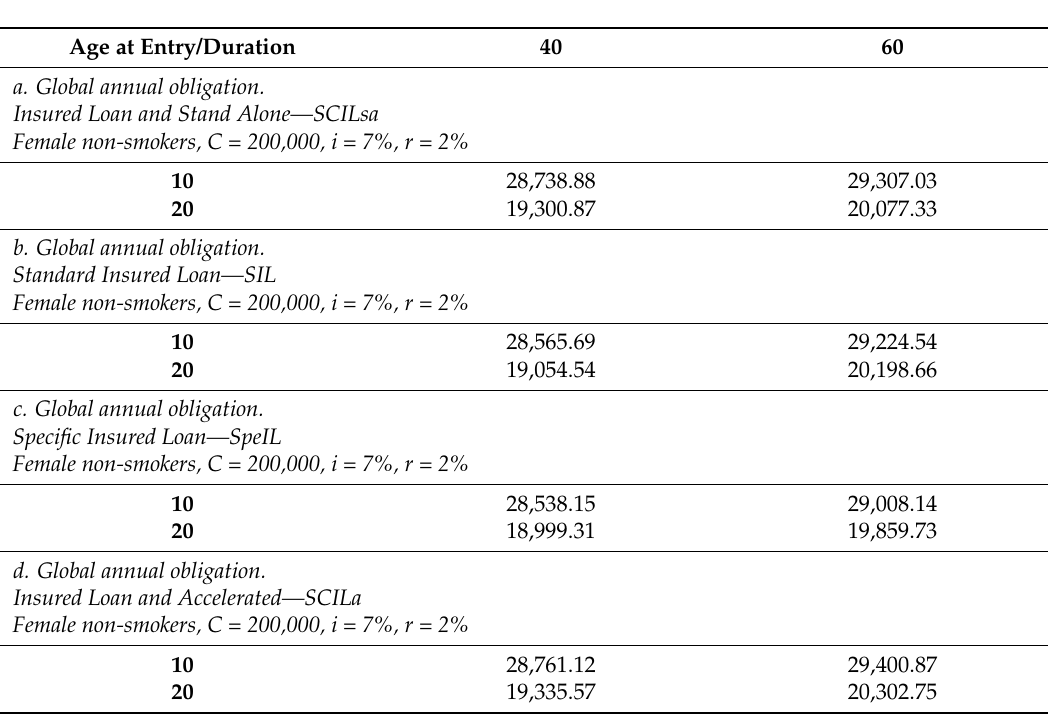
Table 8. Global annual